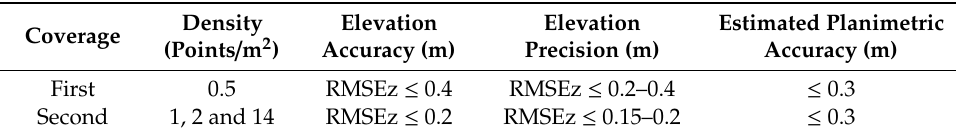
Figure 1. LiDAR data coverage published in the year 2020. Table 2. Technical characteristics of the point clouds resulting from PNOA-LiDAR first and second coverages. Data offered by the Spanish National Geographic Institute through their web page.